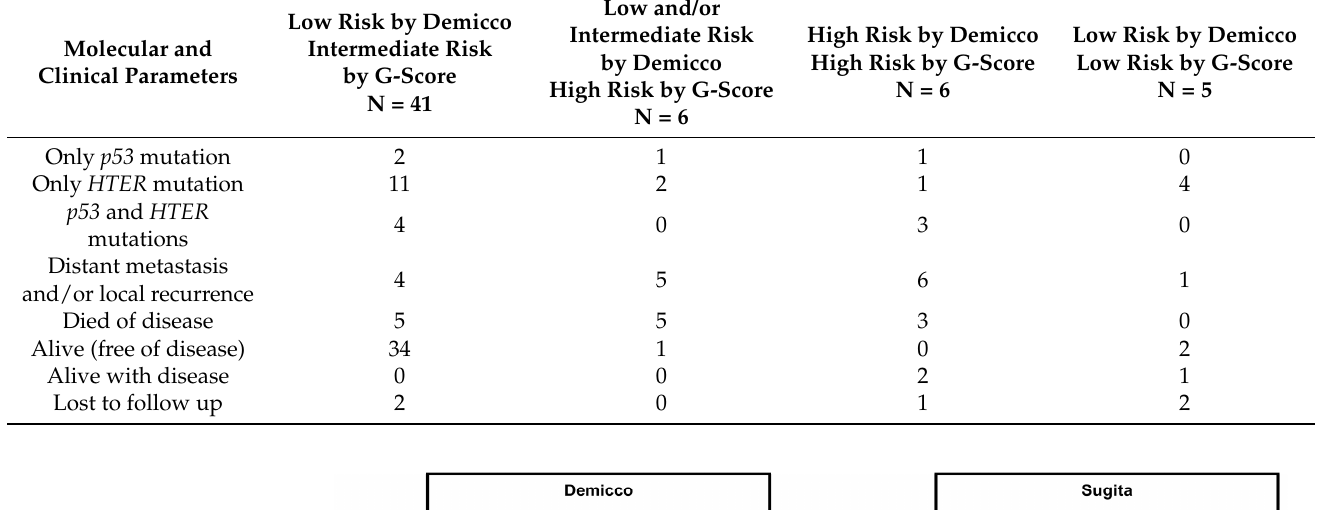
Table 1. Distribution of risk of recurrence and/or metastasis between the three RSS in the present series.